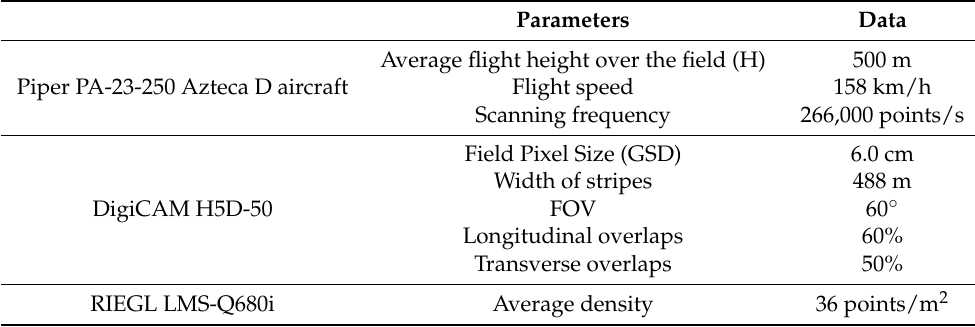
Table 1. Technical specifications of the flight parameters and sensors of the study. Data were acquired in the SRNP-EMSS on 21 May 2021. Abbreviations: GSD = ground sampling distance, FOV = field of